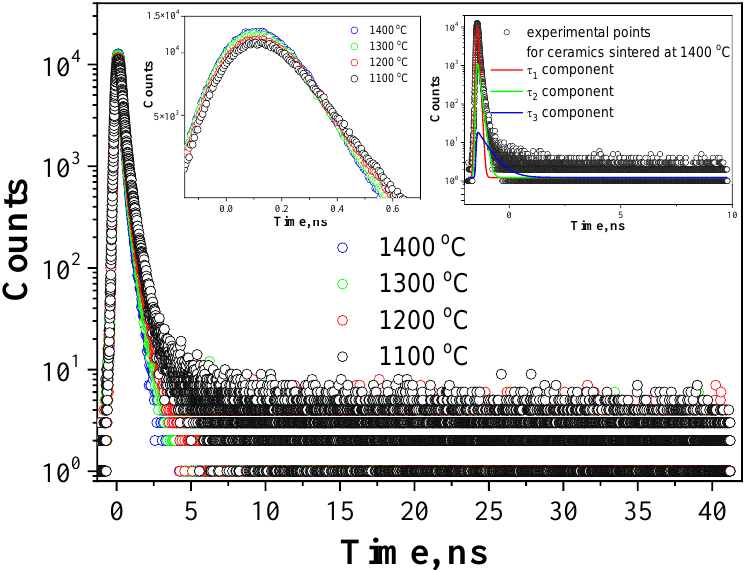
Figure 1. PALS spectra for MgAl 2 O 4 ceramics sintered at 1100 – 1400 °C for 2 h with three components decomposition curves for ceramics sintered at 1400 °C.